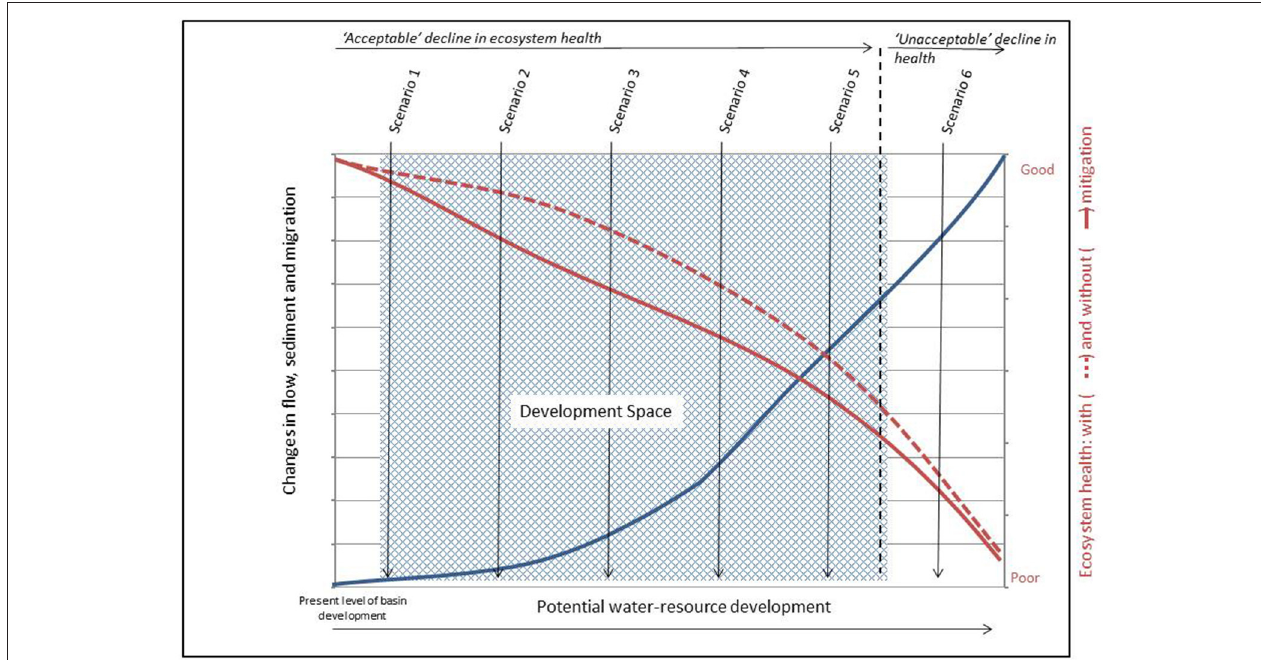
FIGURE 1 | The concept of Development Space, defined by stakeholders after consideration of EFlows scenarios.